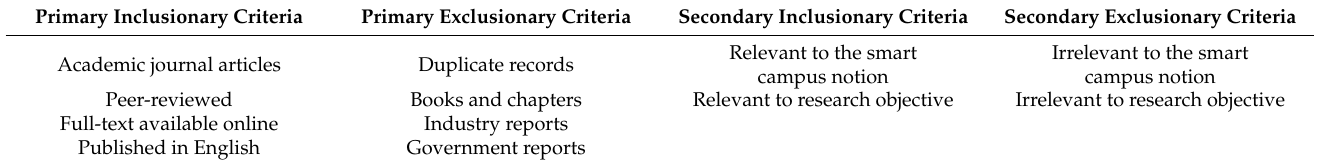
Table 2. Exclusion and inclusion